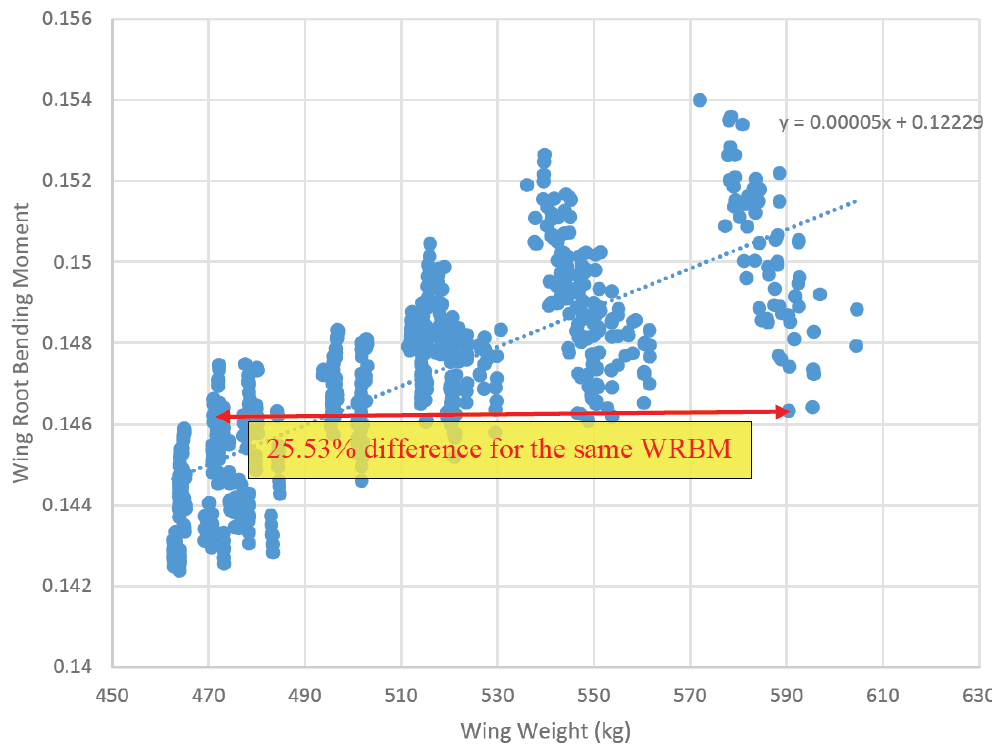
Figure 9. Wing-root bending moment (WRBM) vs . wing weight .